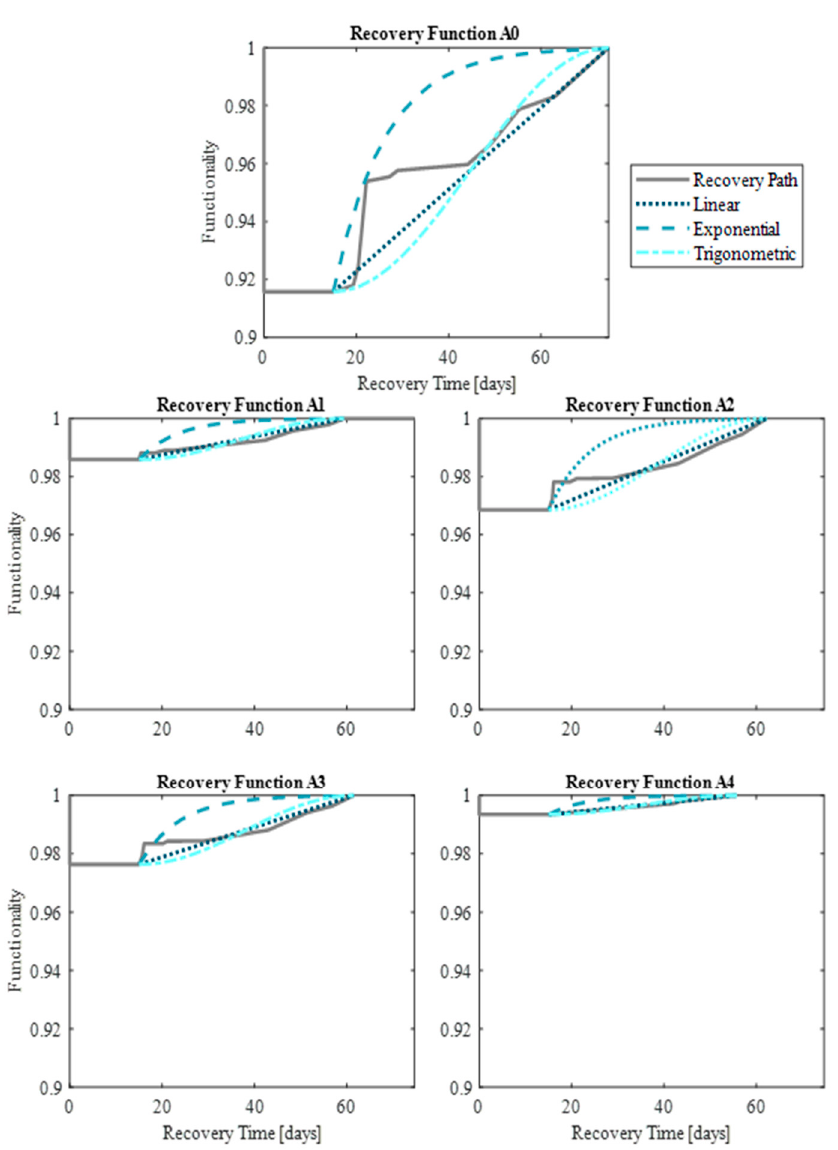
Figure 13. Recovery path for all models at Tr 75 years (SLD).